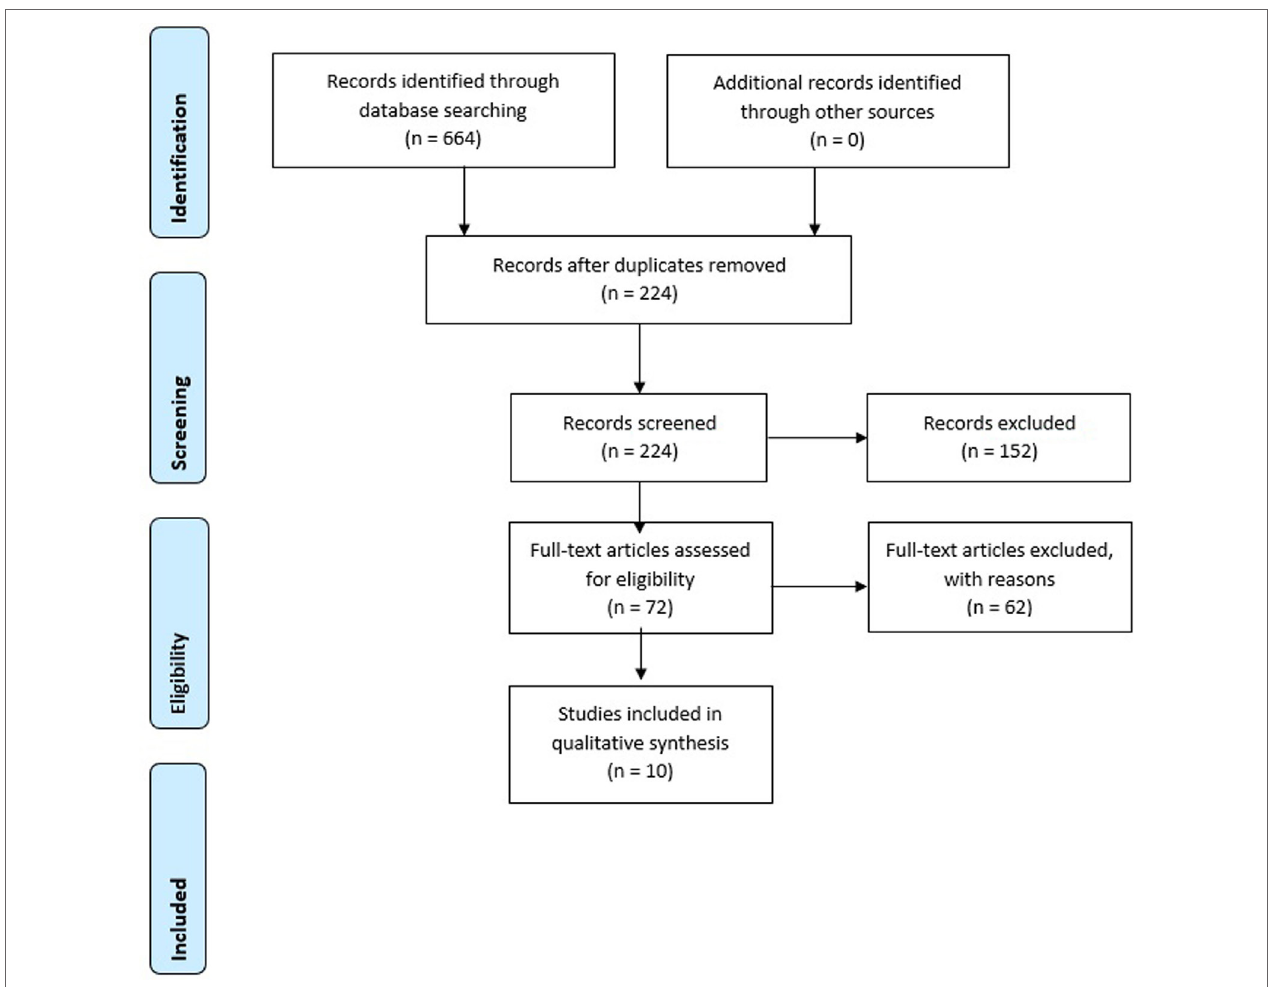
FigURe 1 | Preferred Reporting Items for Systematic Reviews and Meta-Analyses flow diagram of selection of studies. Two articles included in the search results (44, 45) refer to the same study, so the flow chart does not count them